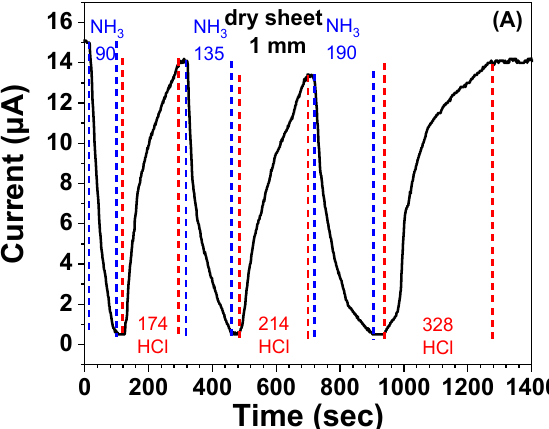
Figure 8. Cyclic response of dry 2-2 cryogel with a thickness of 1 mm to NH 3 and HCl